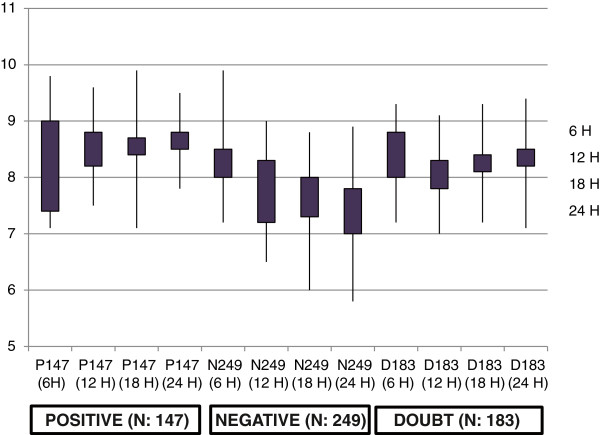
Distribution of calcium levels according to dose and trend.